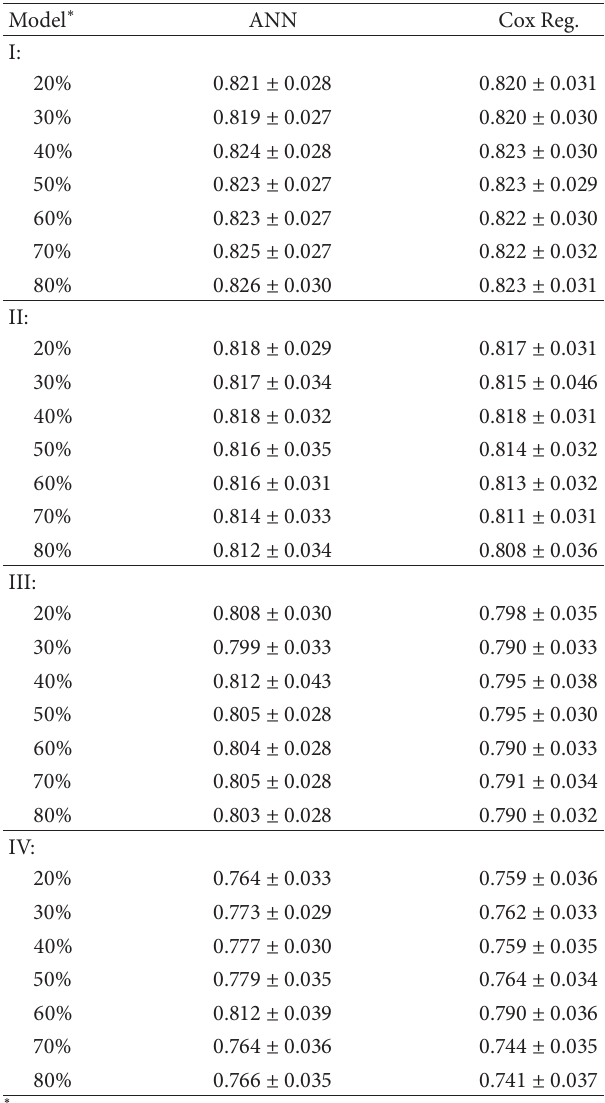
Table 3: Results of concordance indexes of simulation study in testing subset (300 cases with 100